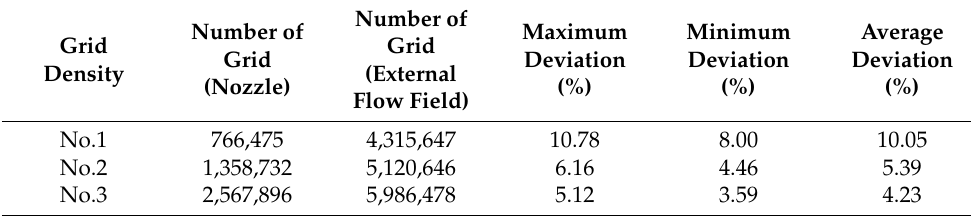
Table 4. Error analysis of the numerical simulation and experimental results.